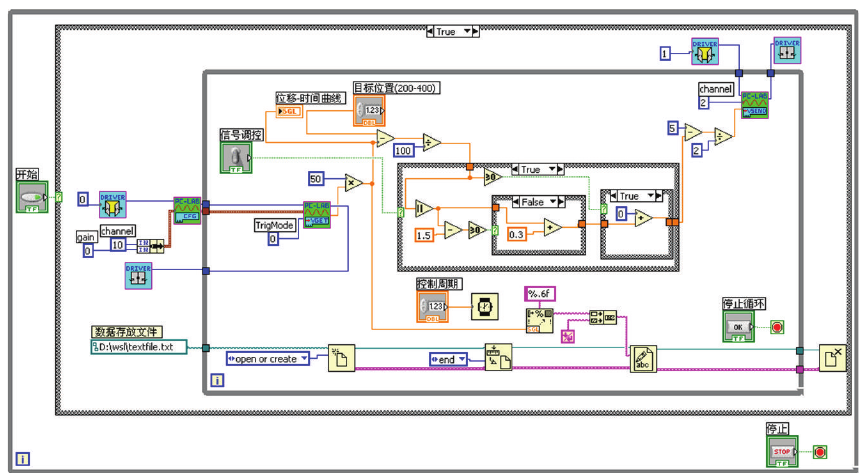
Figure 9: LabVIEW control program diagram.